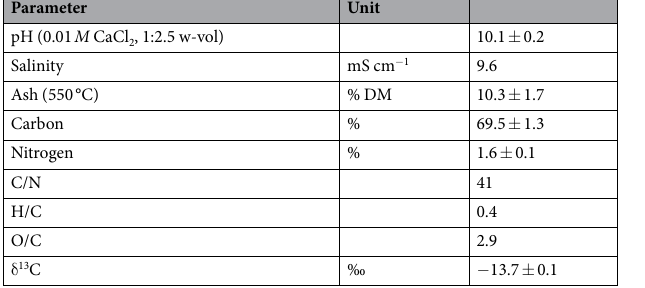
Table 1. General parameters of the